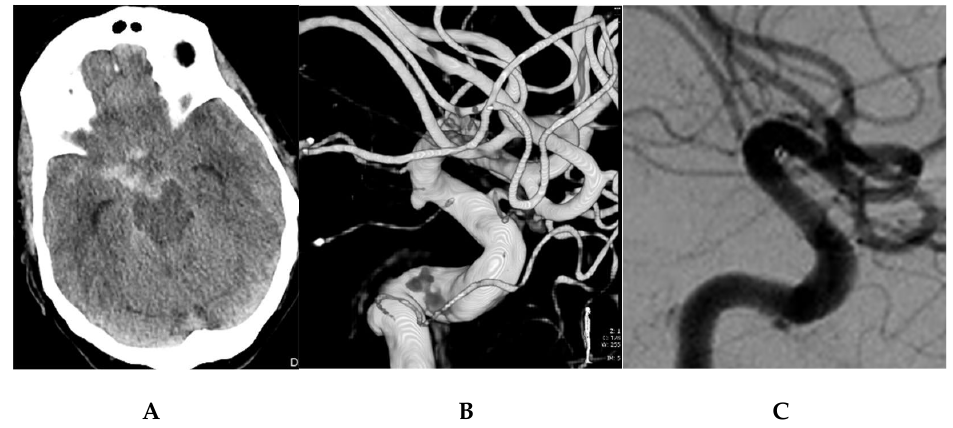
Figure 2. Saccular aneurysm in a 67-year-old female (patient 12). ( A ) Admission CT showing a SAH, Fisher grade 3, centered on the right carotid cistern. ( B ) 3D reconstruction of a rotational angiogram showing a saccular microaneurysm at a nonbranching point of the posterior wall of the supraclinoid right ICA, posterior communicating artery segment. The aneurysm was treated by implantation of a PED 4 × 16 mm FDS on SAH day 3. ( C ) Angiographic follow-up obtained after 5 months showing complete exclusion of the treated aneurysm and no sign of in-stent stenosis. All 15 patients presented with spontaneous SAH detected on admission CT.